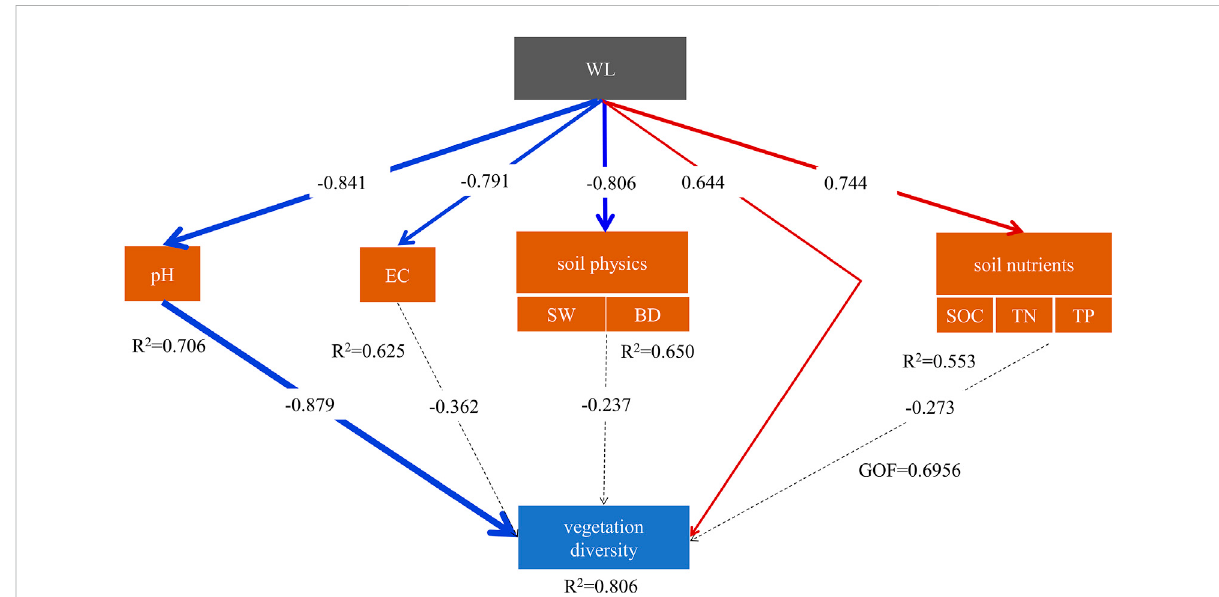
FIGURE 7 Analysis of the relationship between environmental factors and plant diversity (WL, Water level; EC, Water conductivity; BD, Bulk density; SW, Soil moisture content; SOC, Soil organic carbon; TN, Total nitrogen; TP, Total phosphorous). The arrows in the fi gure denote path relationships, and the numbers above the arrows denote path coef fi cients. The red line denotes a signi fi cant positive effect, and the blue line denotes a signi fi cant negative effect. A thicker line denoted a higher level of signi fi cance. The dotted line denotes no signi fi cant effect. R 2 denoted the variance of model interpretation. The model was assessed using the goodness of fi t (GoF) statistic, a measure of overall prediction